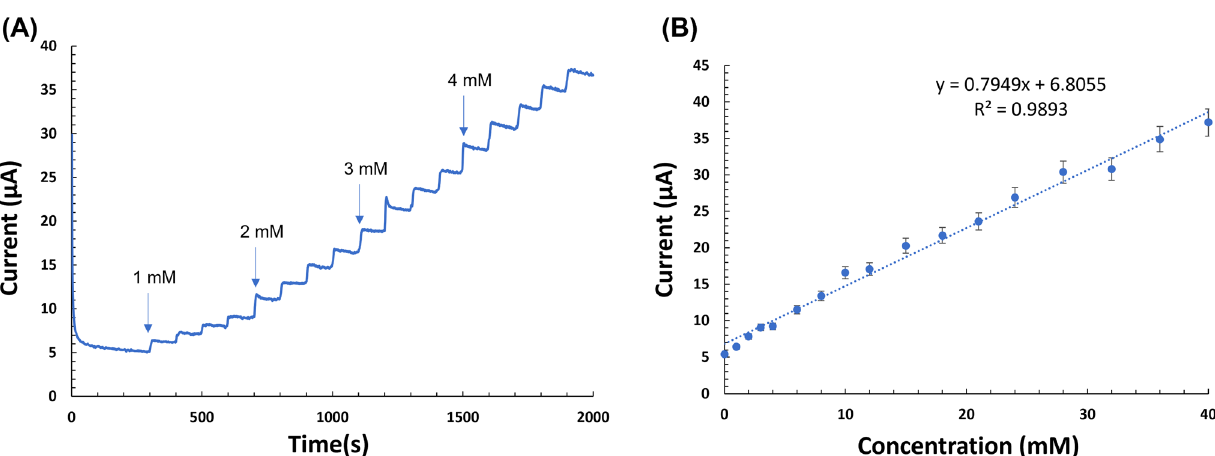
Figure 4. ( A ) Chronoamperometry of co–Pt upon successive additions of glucose (applied potential: − 0.1 V) in 0.1 M PBS pH 7.4. ( B ) Corresponding calibration curve. Error bars: ± standard deviation of triplicate